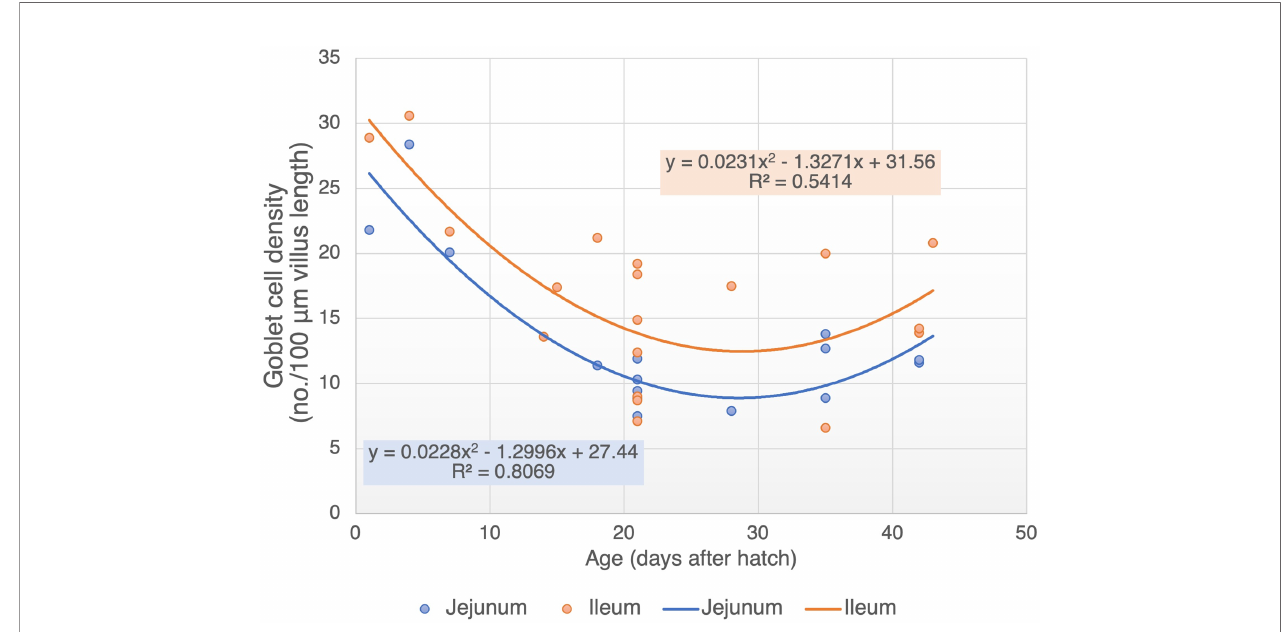
FIGURE 2 | Goblet cell density in jejunum and ileum of broiler during age development (cell number per 100 µm villus length). Adapted data from references (6, 8 –